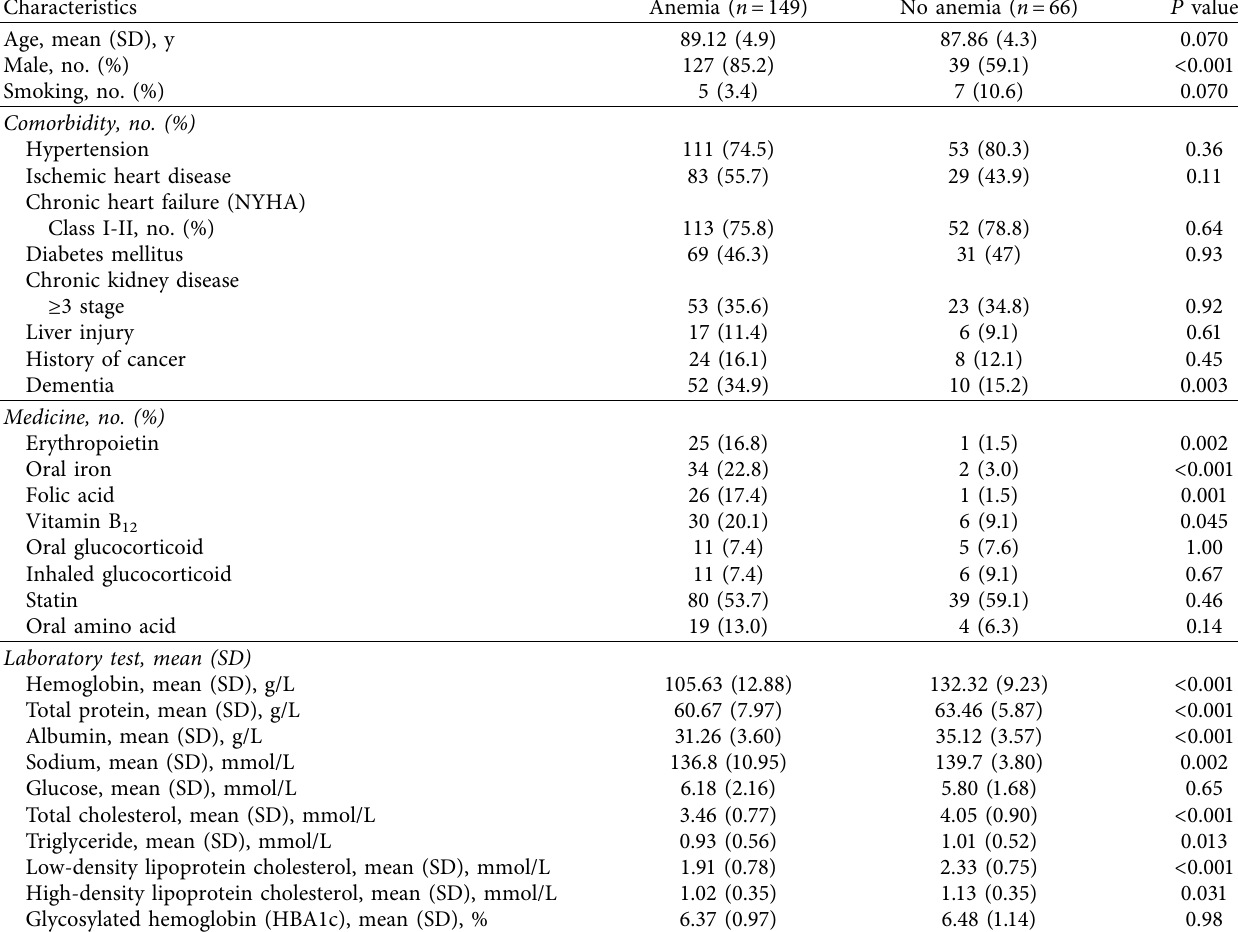
Table 1: Baseline characteristics of the study population.